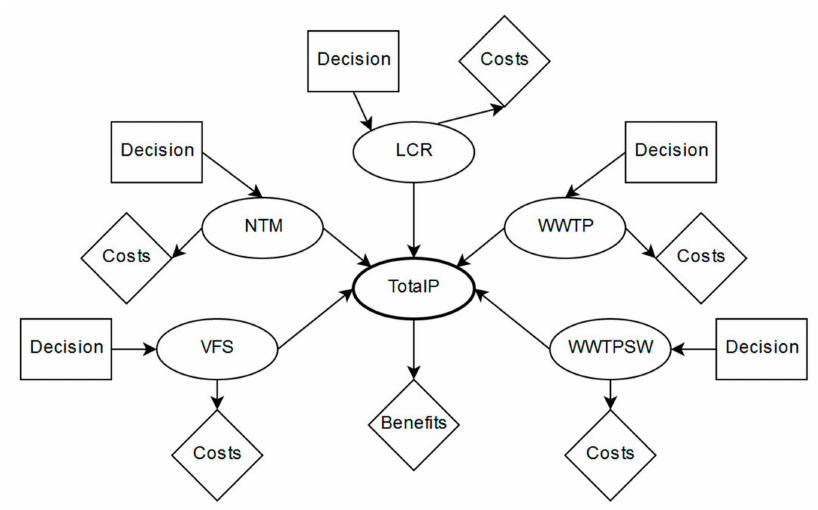
Figure 3. Influence diagram of phosphorus abatement including the Bayesian network.